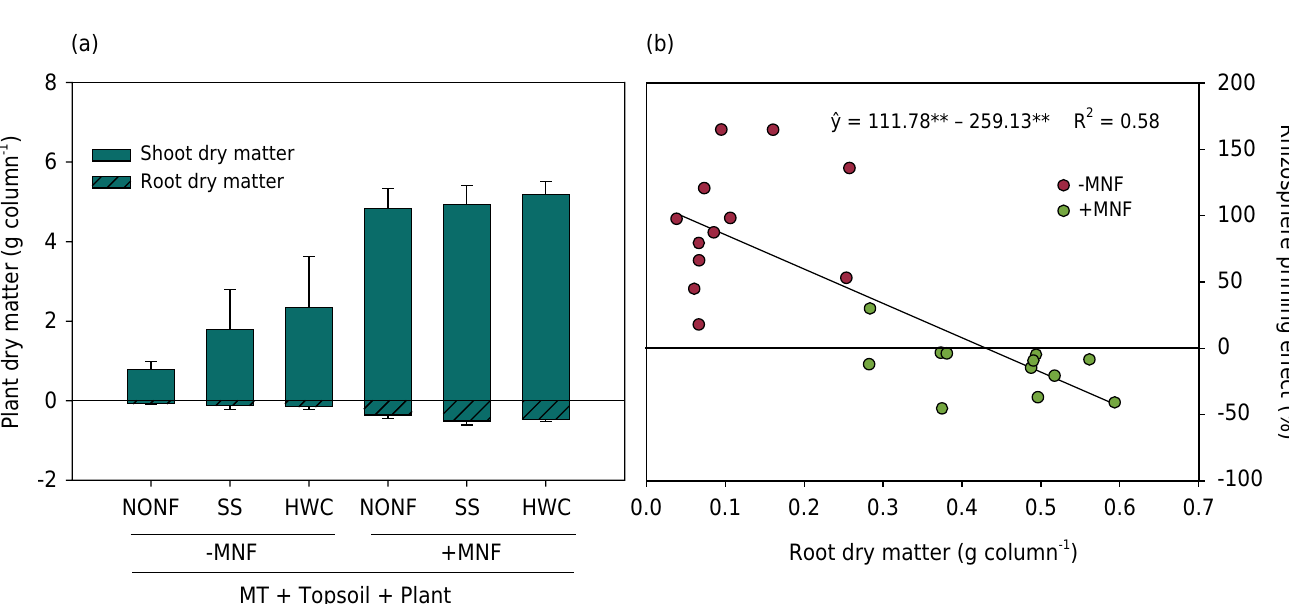
organic fertilization increased by 2.58 g of shoot dry matter per column (Figure 6a and Table 5; C : p<0.01), while the root dry matter was not affected by organic fertilization 8 (Figure 6a and Table 5; C : 0.12 g per column p>0.10). Opposite behavior was observed 8 in the soils with +MNF application, which the organic-N fertilization did not affect the shoot dry matter (Figure 6a and Table 5; C : 0.45 g per column p>0.10) but improved 10 the root dry matter (Figure 6a and Table 5; C : 0.26 g per column p<0.01). The mineral-N 10 fertilization increased the shoot dry matter (C : 5.52 g per column p<0.01) and root dry A2 (Figure 6a and Table 5). The Root DM showed linear adjustment with rhizosphere priming effect (%), regardless of mineral-N fertilization (-MNF and +MNF; Figure 6b).